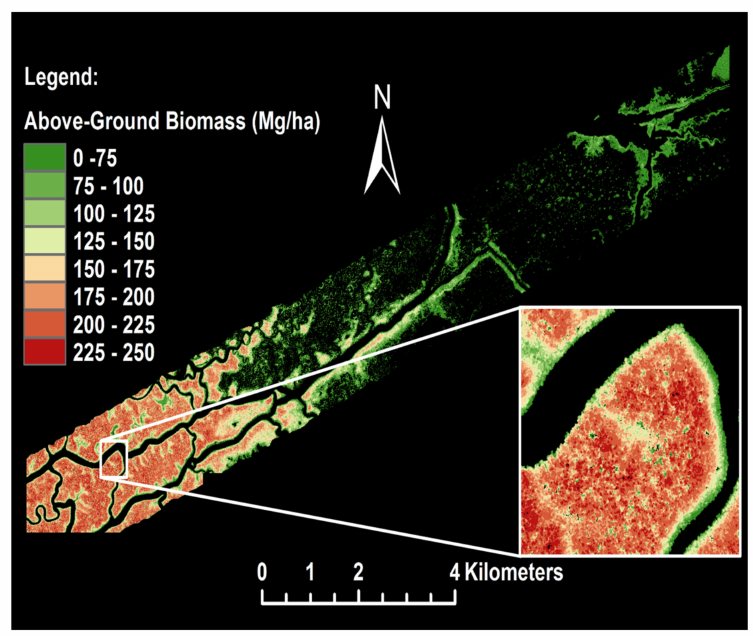
Figure 9. SRS mangrove above-ground biomass (AGB) map based on 2012 ALS canopy height data and Simard et al. [3] ENP mangrove height to AGB equation.